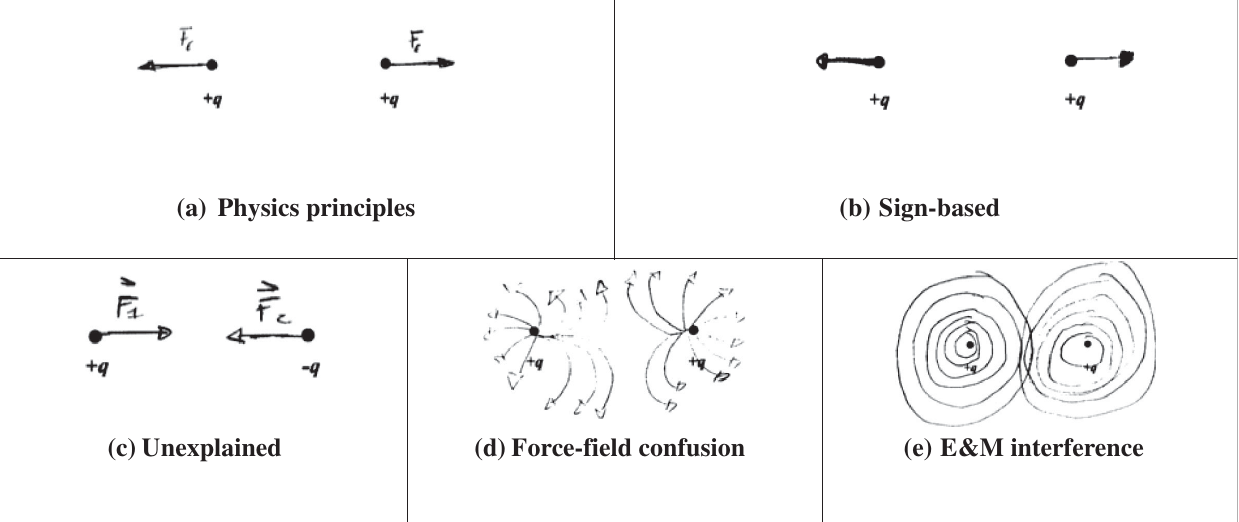
FIG. 7. Examples of the diagrams drawn by students for each category in the electricity version of the test. Examples a, b, d, and e were answers for item 1, and example c was a response for item